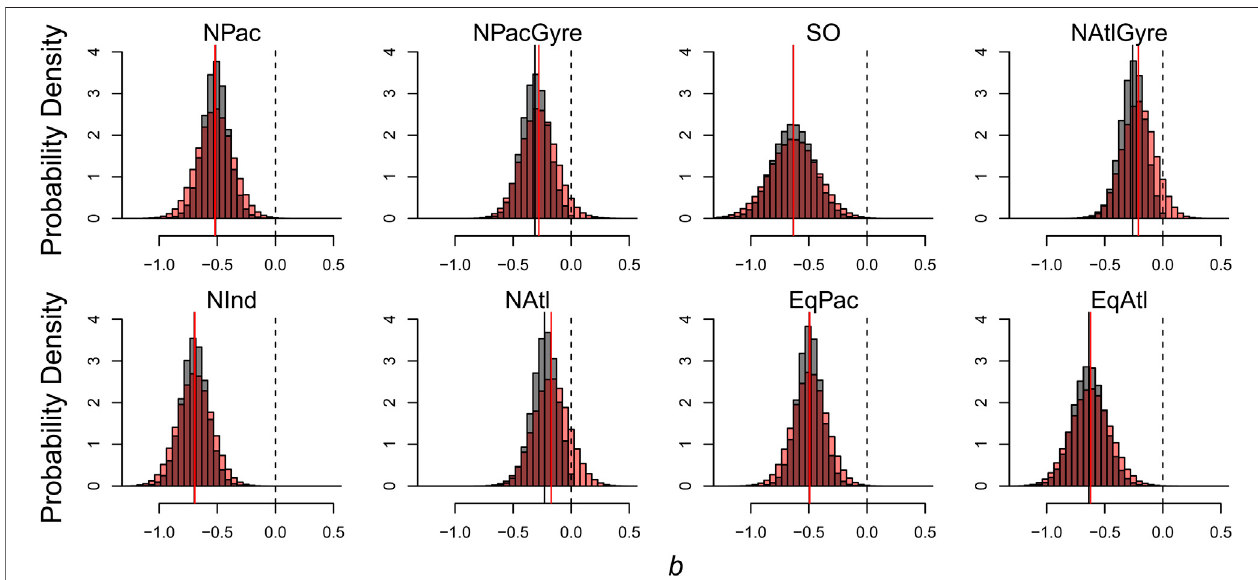
FIGURE 6 | Effects ofinformative prior distributions on posterior model parameters. Shown are posterior distributions for b based on two forms of the model: gray histograms show posteriors for the model with the prior constraint that b is non-positive; red histograms show posteriors without the prior constraint.